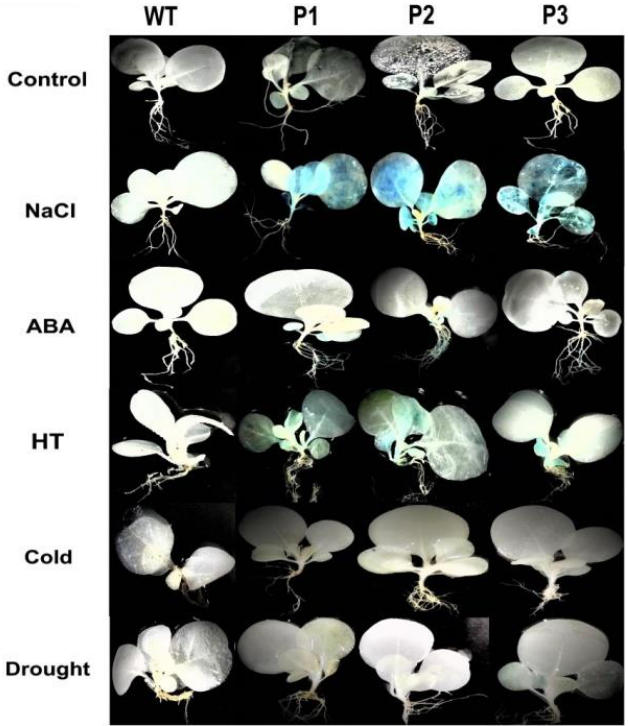
Figure 3. GUS activity analysis of the PsnNAC036 promoter under different treatments.